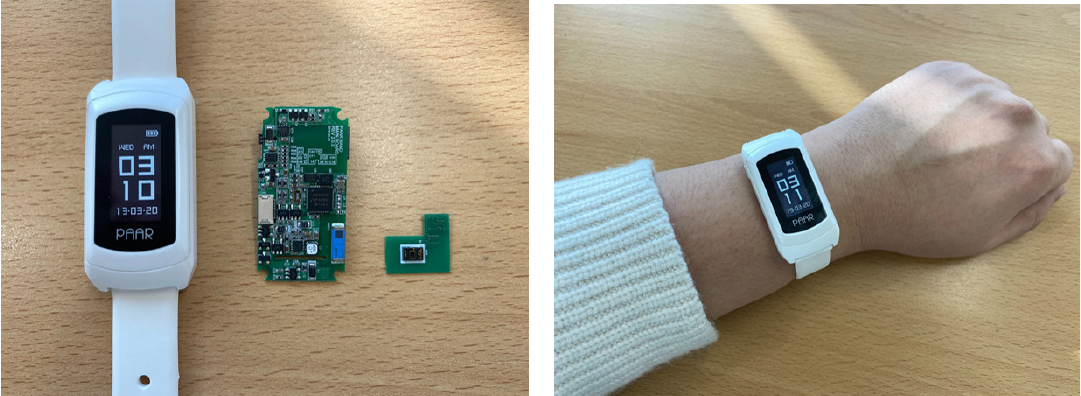
Figure 12. Implementation of Mobile Identification Device (Smart Band Type).